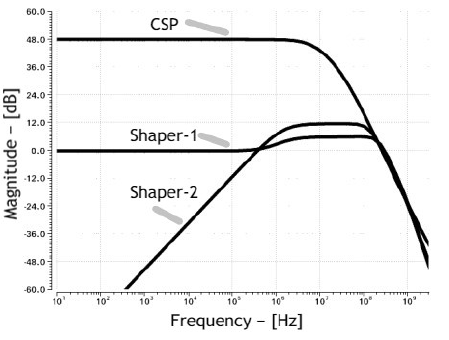
Figure 7. CSP and shaper stage (1–2) frequency response.